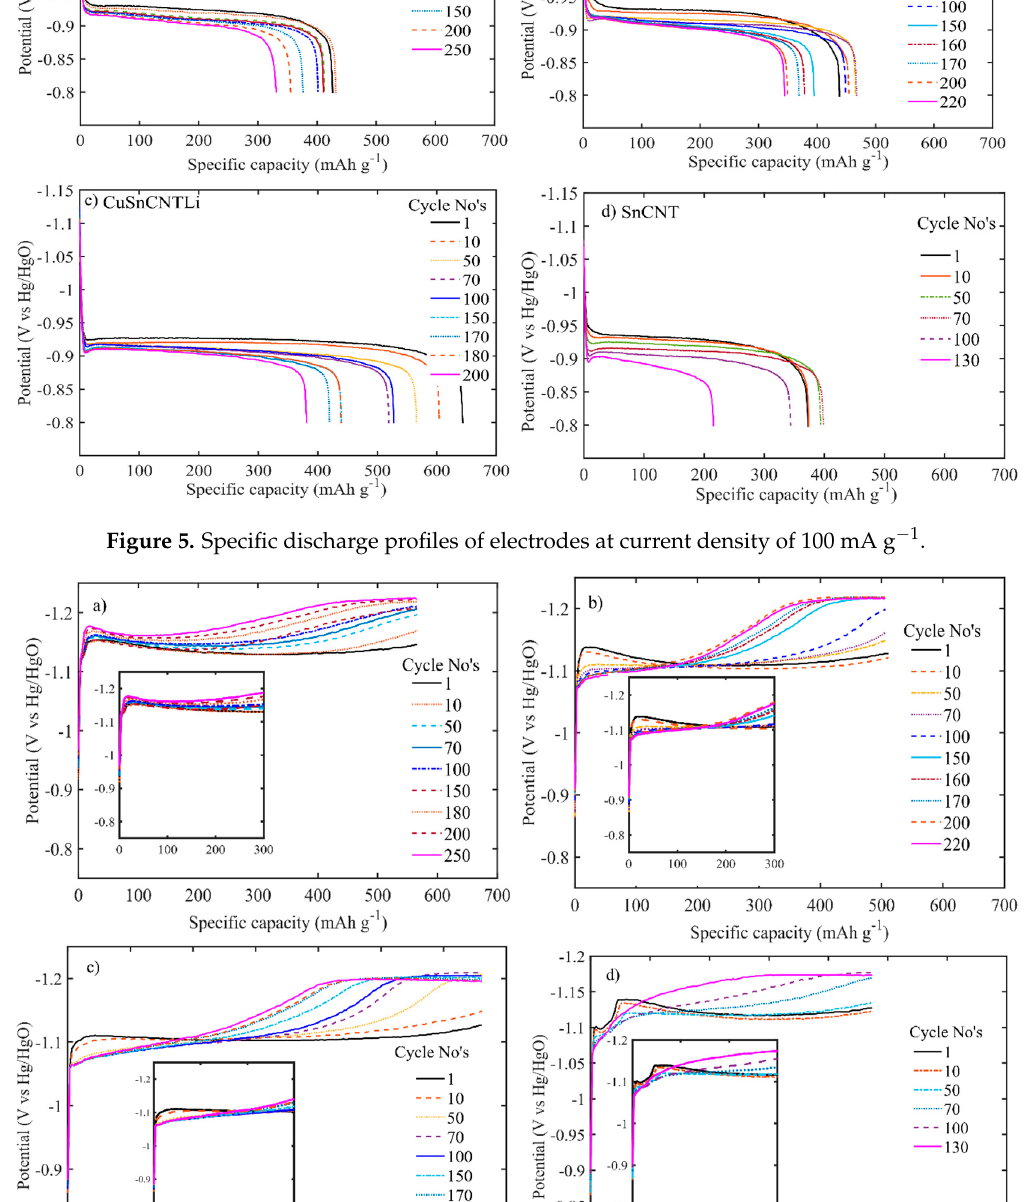
Figure 6. Specific charge profiles of electrodes at current density of 200 mA g − 1. (inset figure-Potential overshoot along the cycles). ( a ) CuSn; ( b ) CuSnCNT; ( c ) CuSnCNTLi; ( d ) SnCNT.